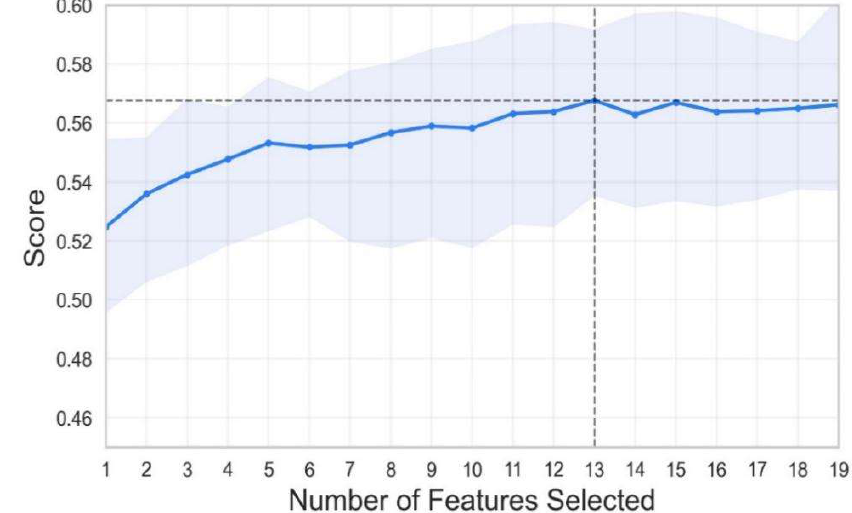
Figure 2. RFE feature selection results of XGBoost.